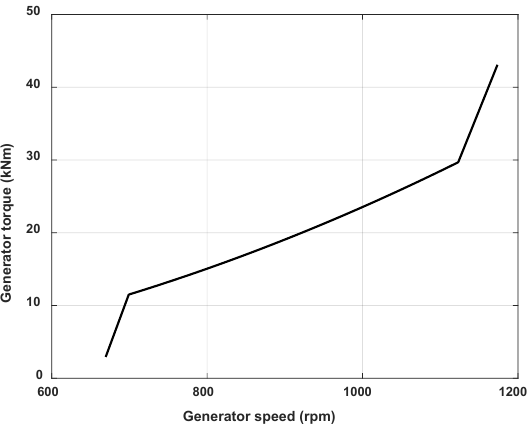
Figure 4. A look-up table curve between the generator speed and generator torque. In the rated power region, the control strategy is to maintain the rated power of the target wind turbine by adjusting the pitch angle of the blades. For this, the generated torque is fixed to the rated value, and a PI control algorithm is used to adjust the blade pitch angle to minimize the error between the rated generator speed and the measured generator